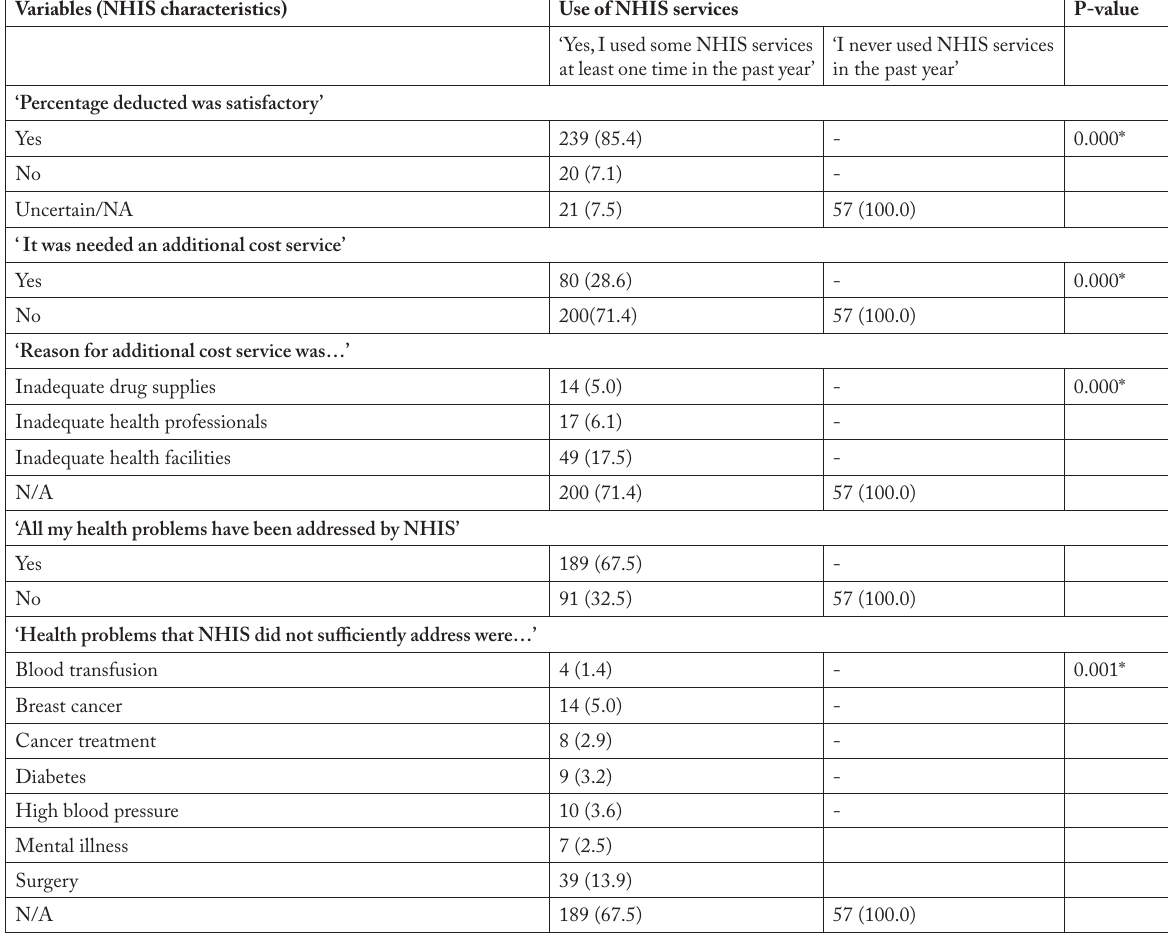
Table 3. Predictors of patient satisfaction and self-rated health by multiple regression analysis ( n =